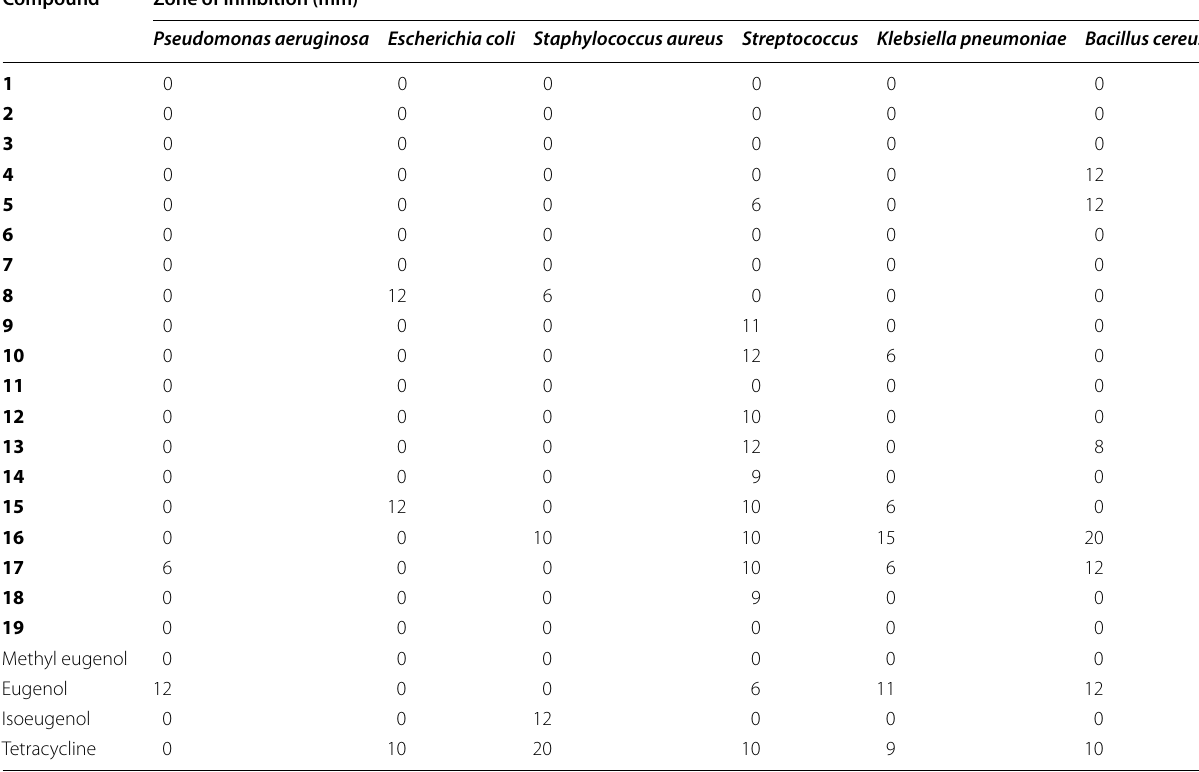
Table 1 Effect of eugenol derivatives against six bacterial strains Compound